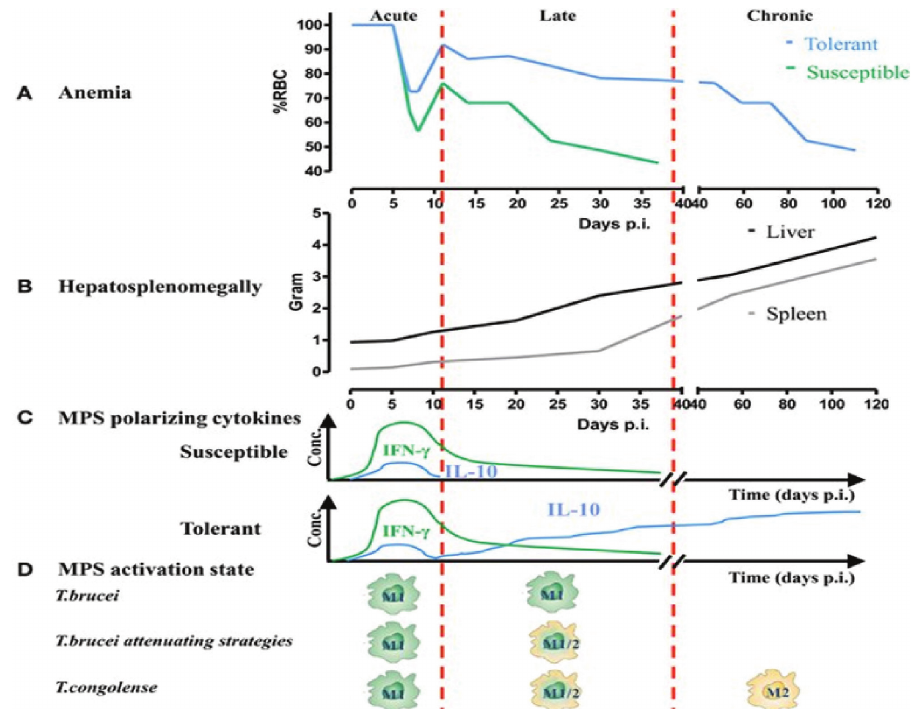
Figure 1: The activation state of myeloid cells associated with anemia development during trypanosomiasis in trypanotolerance and trypano-susceptible cattle [71]. (A) Anemia development in trypanosusceptible (green) and trypanotolerant (blue) animals during the course of infection. Anemia progression can be divided into (i) an acute phase characterized by a rapid drop in red blood cell (RBC) numbers (i.e., consumptive anemia) followed by a partial recovery phase, (ii) a late stage characterized in the susceptible model by a progressive decline in RBC numbers (below that of the acute phase) and host death. In the tolerant model, this decline is less pronounced and leads to (iii) a chronic phase (i.e., progressive anemia), whereby RBC numbers keep on declining till finally reaching levels of that of the acute phase. (B) Throughout the course of infection progressive hepatosplenomegaly occurs, whereby the onset of splenomegaly precedes hepatomegaly. At the late/chronic stage of infection, splenomegaly is more pronounced than hepatomegaly. (C) During the different stages of infection, the host produces different mononuclear phagocyte system (MPS) polarizing molecules. During the early/acute stage, both trypanosusceptible (upper, green) and trypanotolerant (lower, blue) animals produce IFN-γ (green line) required to trigger the induction of classically activated macrophages (M1), which is followed by a moderate induction of IL-10 (blue line) to dampen the pathogenic effects of the M1. Only in the trypanotolerant model, there is a second progressive increase in IL-10 during the late/chronic phase of infection, which is required to induce alternatively activated macrophages (M2). (D) Occurrence of M1 and M2 during the course of aggressive Trypanosoma brucei or T. brucei attenuating strategies (GPI-based strategy or AAV-10/anti-CD28) or less virulent T. brucei PLC−/−/ Trypanosoma congolense